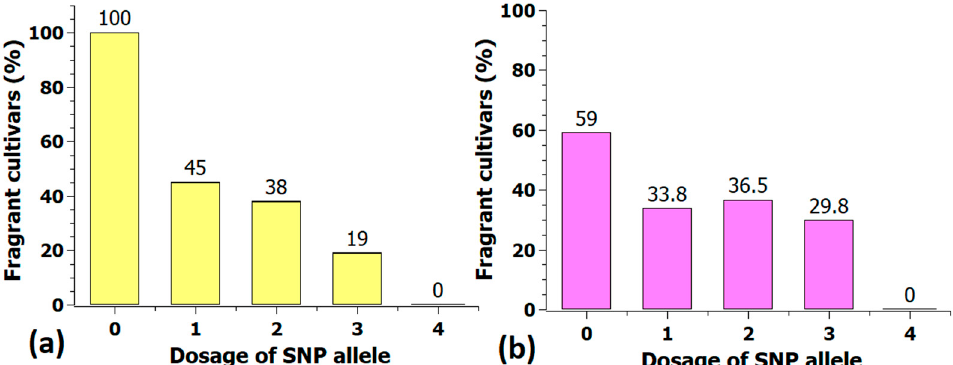
Figure 12. Percentage of fragrant cultivars (fragrance score ≥ 2) in the five marker classes of the KASP marker Rh_FR_SNP201K in the association panel ( a ) and in the validation population with 282 cultivars ( b ). Shown above the columns are the percentages of fragrant cultivars.